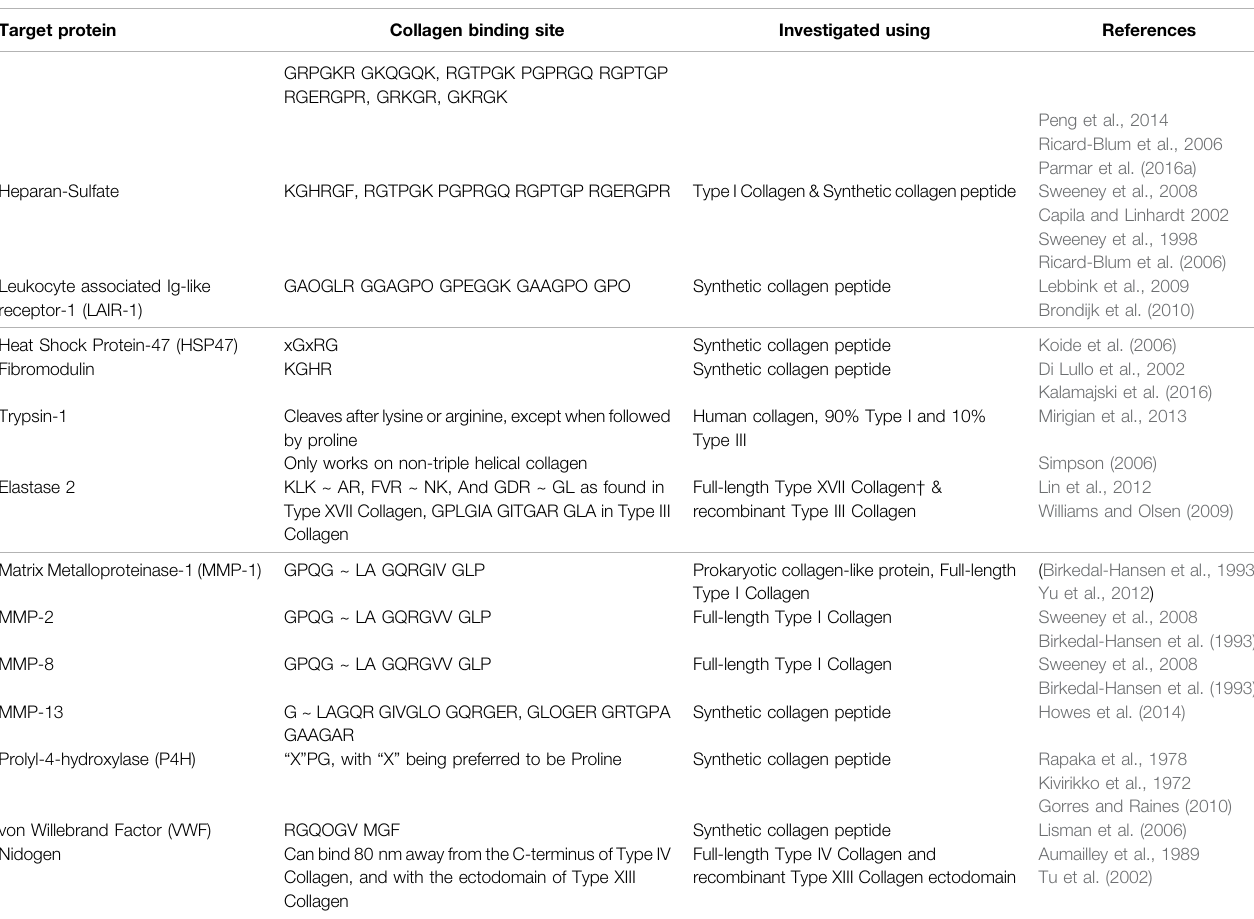
TABLE 2 | ( Continued ) Binding sites on human collagen to various ECM proteins and cellular receptors. Symbol De fi nition: * - computational modeling used to de fi ne residues,~denotesproteasecutsiteintheproteinsequence, † proteasecutsitewasdeterminedusingMassSpectroscopy, “ O/P ” meansthatbothhydroxyprolineand proline have been used and were shown to interact, “ x ” represents any amino acid unless otherwise